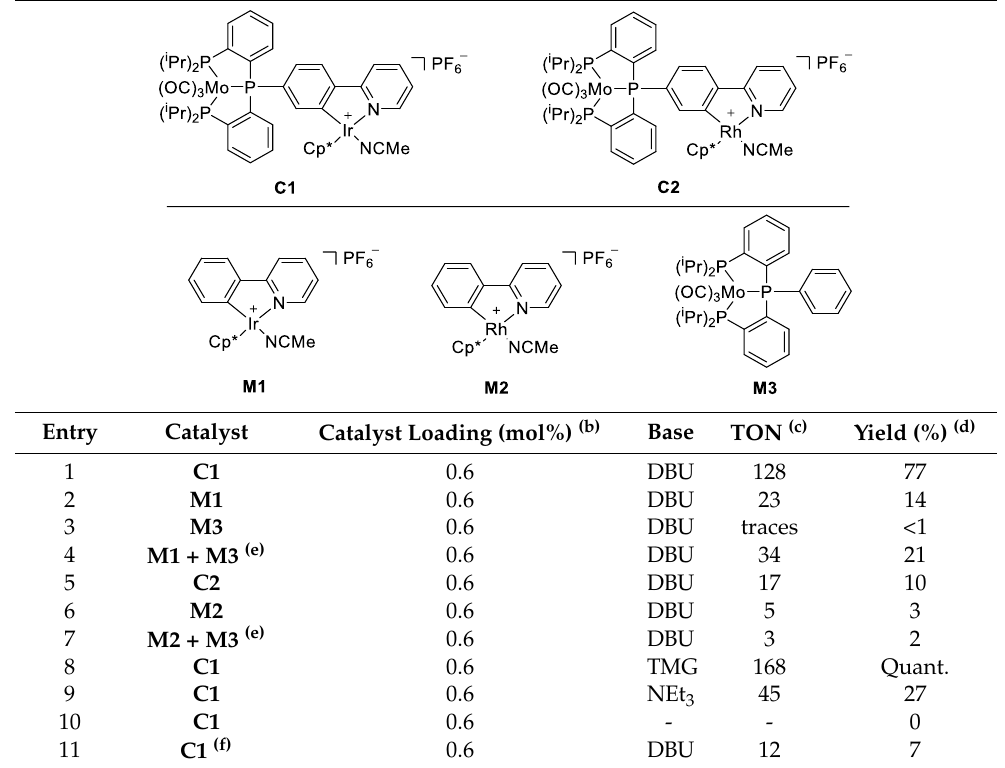
Table 1. Catalytic CO 2 hydrogenation to formate using different complexes and bases (Cp* = C 5 Me 5 ). (a)